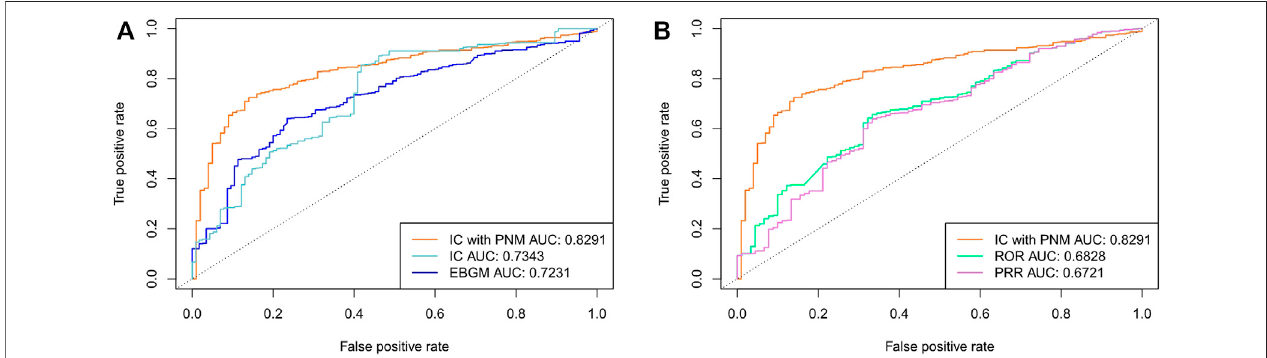
FIGURE 4 | (A) Comparison of performances of IC PNM , IC, and EBGM with SIDER data as the testing set using FAERS 2014-2019Q2 data (B) Comparison of performances of IC PNM , ROR, and PRR with SIDER data as the testing set using FAERS 2014-2019Q2 data.